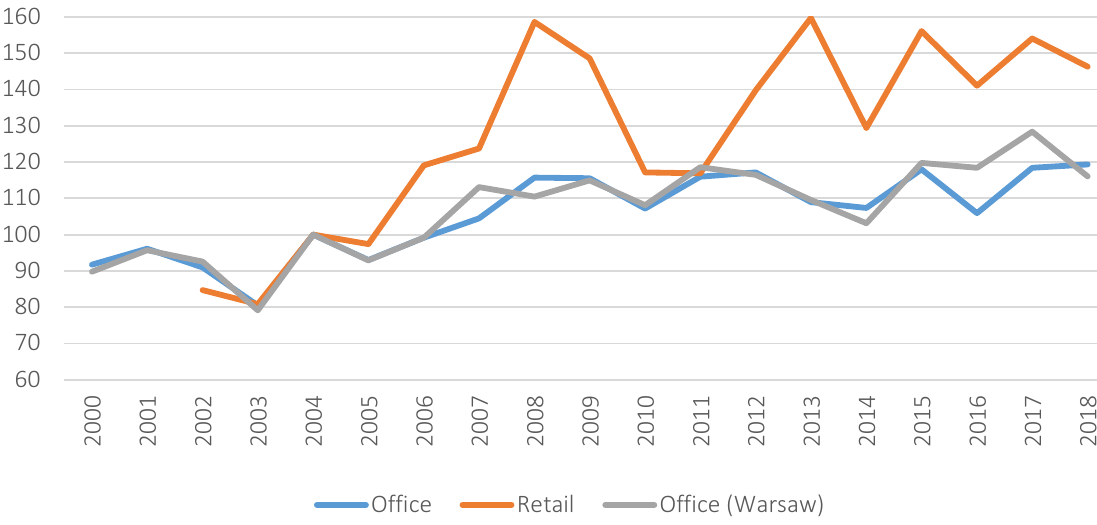
Figure 7. The office and retail price index (2004 = 100) in